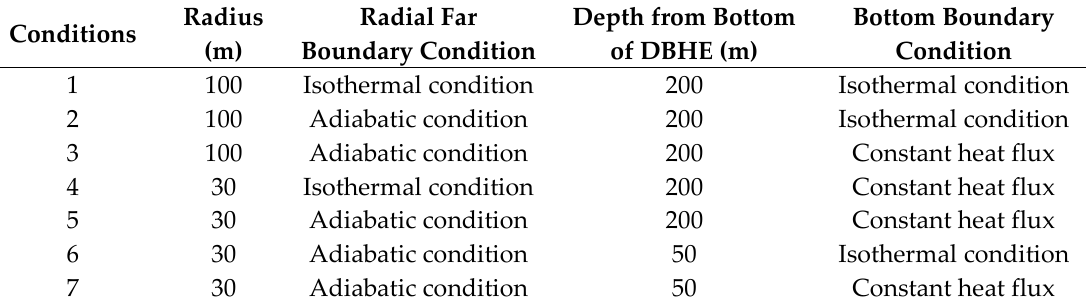
Figure 28. Variation of heat extraction in long-term with different boundary conditions. Table 7. Boundary condition set of radial far boundary and bottom